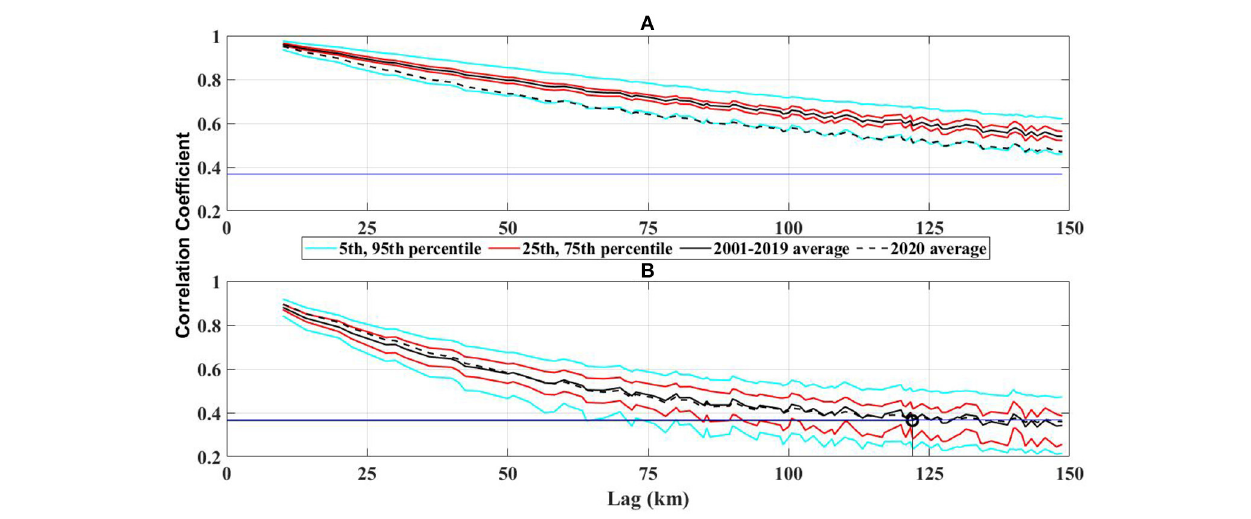
FIGURE 7 | Variogram of spatial correlations for a daily precipitation in the (A) Hubei province during January-April, 2001–2020 and (B) Northern Italy during March-May, 2001–2020, showing the mean, 5th, 25th, 75th, and 95th percentiles for 2001–2019 period and the mean for 2020. The horizontal solid line represents a correlation value of 1/e and the corresponding decorrelation